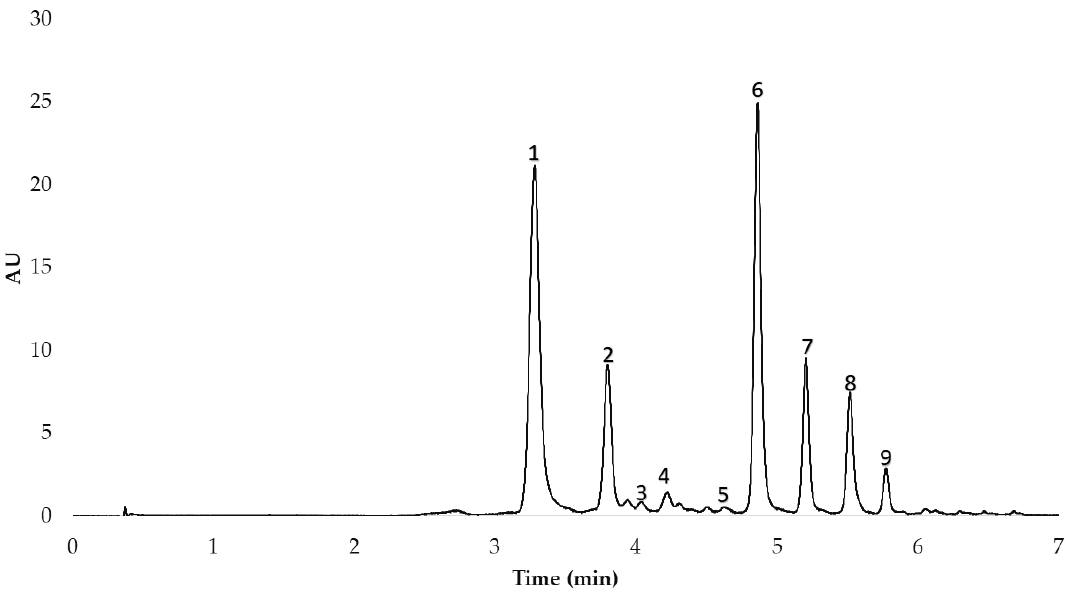
Figure 1. HPLC chromatogram of the nine anthocyanins identified in the MAE extracts from red onion. 1. cyanidin 3- O -glucoside; 2. cyanidin 3- O -laminaribioside; 3. cyanidin 3- O -(3 ″ -malonylglucoside); 4. peonidin 3- O -glucoside; 5. delphinidin 3,5- O -diglucoside; 6. cyanidin 3- O -(6 ″ -malonylglucoside); 7. cyanidin 3- O -(6 ″ -malonyl-laminaribioside); 8. peonidin 3- O -(6 ″ -malonylglucoside); 9. delphinidin 3- O -glucoside.